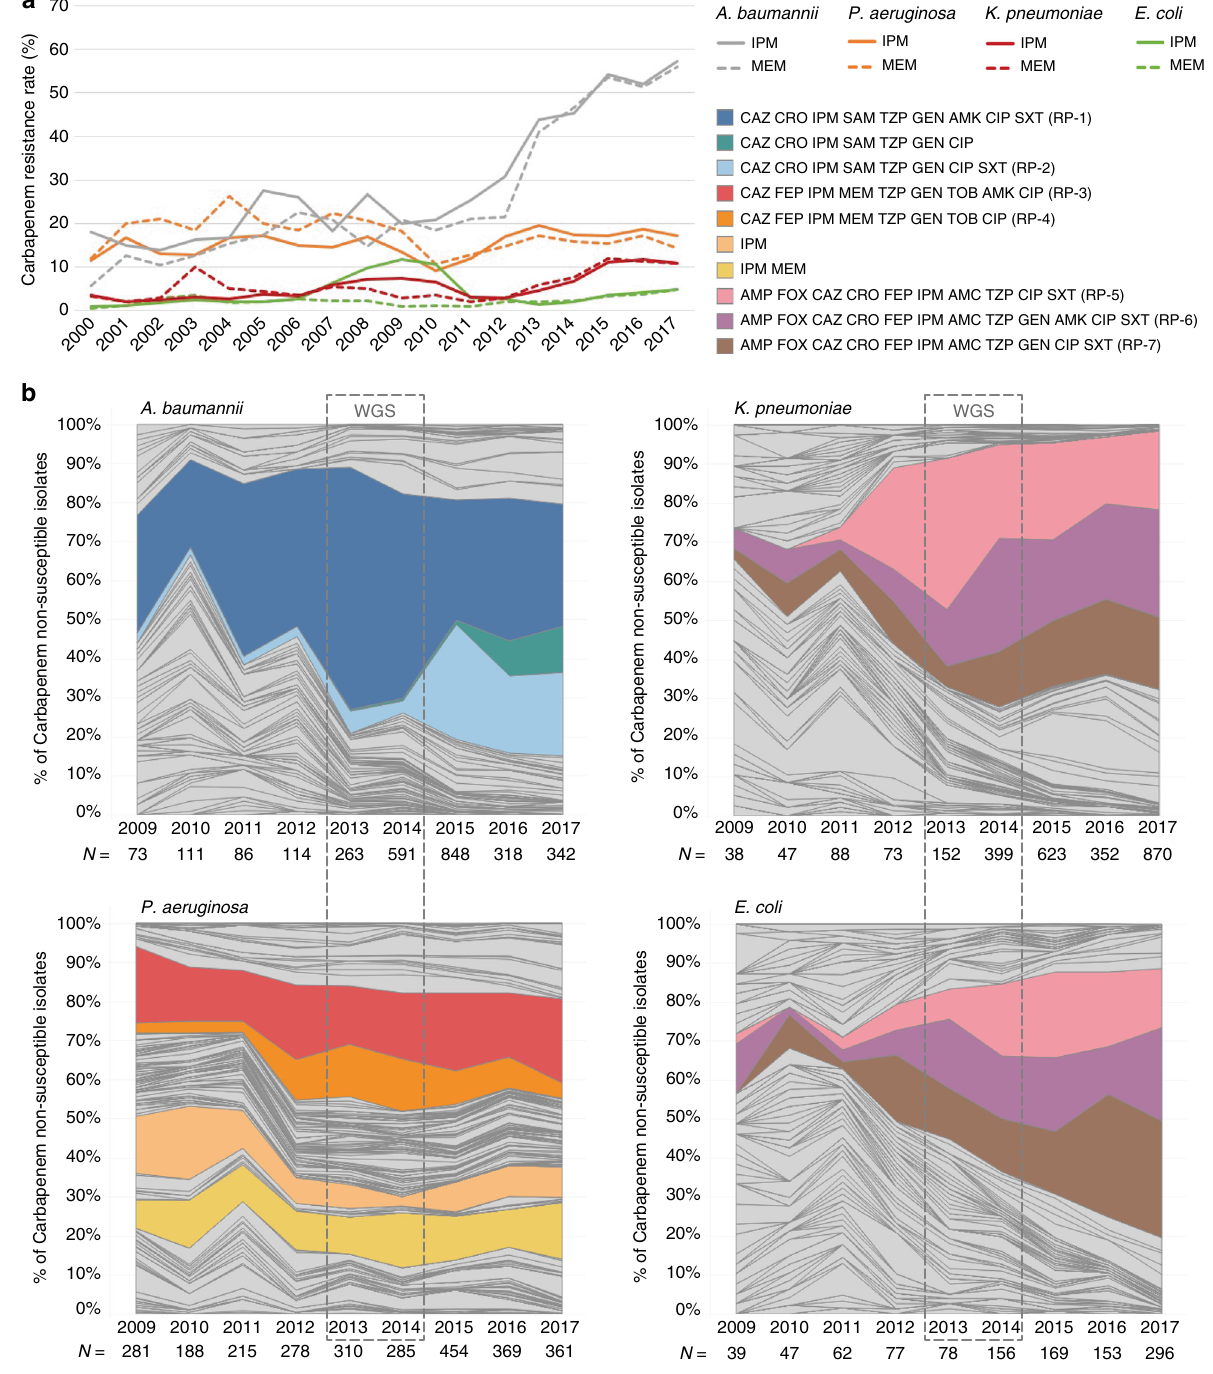
Fig. 2 Temporal dynamics of carbapenem resistance pro fi les. a Yearly carbapenem resistance rates (IPM imipenem, MEM meropenem) for A. baumannii , P. aeruginosa , K. pneumoniae and E. coli . b Relative abundance of carbapenem resistance pro fi les (non-susceptible to imipenem and/or meropenem). The three-letter antibiotic codes (as in Table 1) indicate that the isolate is non-susceptible (resistant or intermediate). Only carbapenem non-susceptible isolates with complete susceptibility data were included, as indicated by the numbers under the x -axis (N). WGS box: period covered by the retrospective whole-genome sequencing